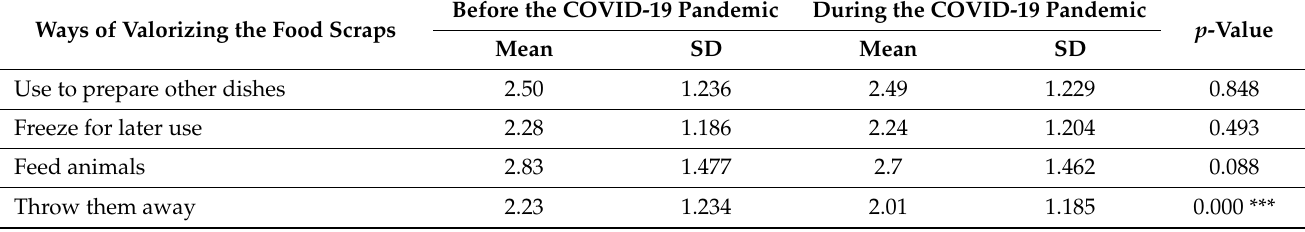
Table 6. Ways of valorizing the food scraps before the COVID-19 pandemic and during the COVID-19 pandemic.